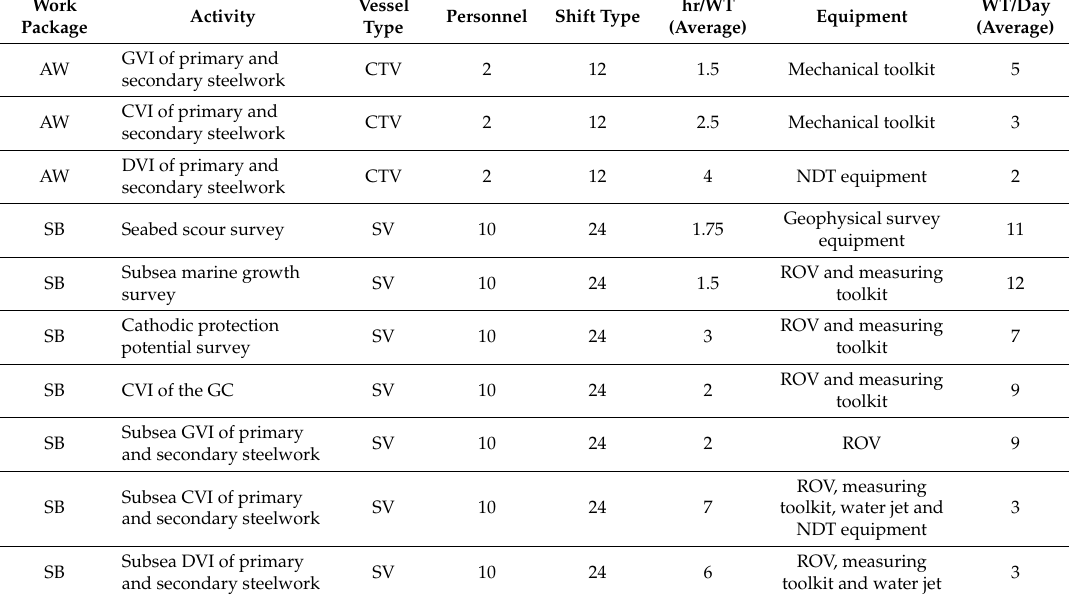
Table 13. Activities specifications: vessel type, personnel, working time and